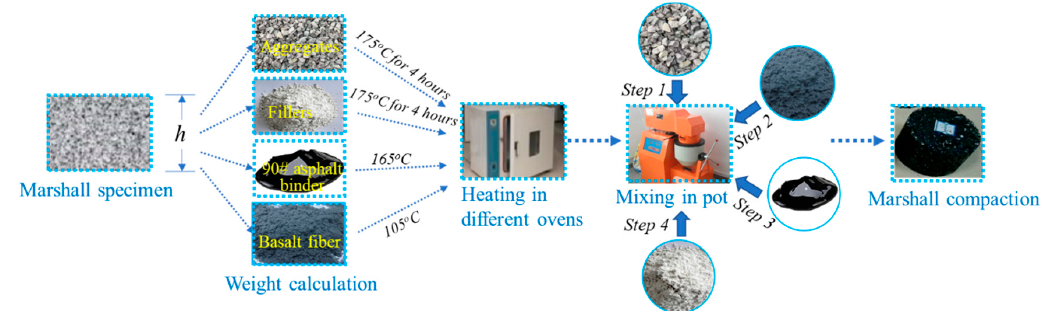
Figure 6. Graphical procedures of Marshall specimen preparation.